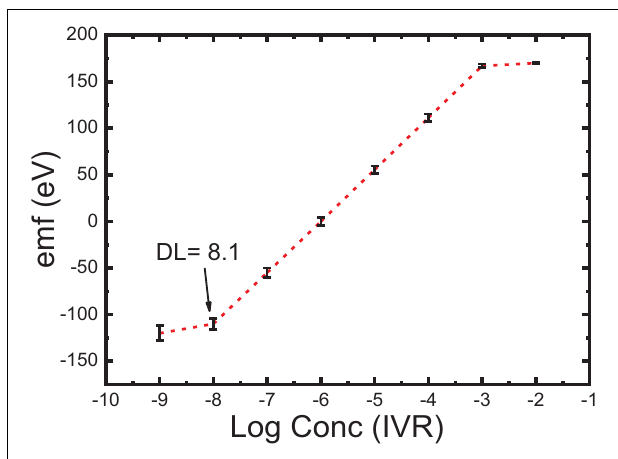
FIGURE 7 | Calibration curve, concentration range, and detection limit of sensor 5, with error